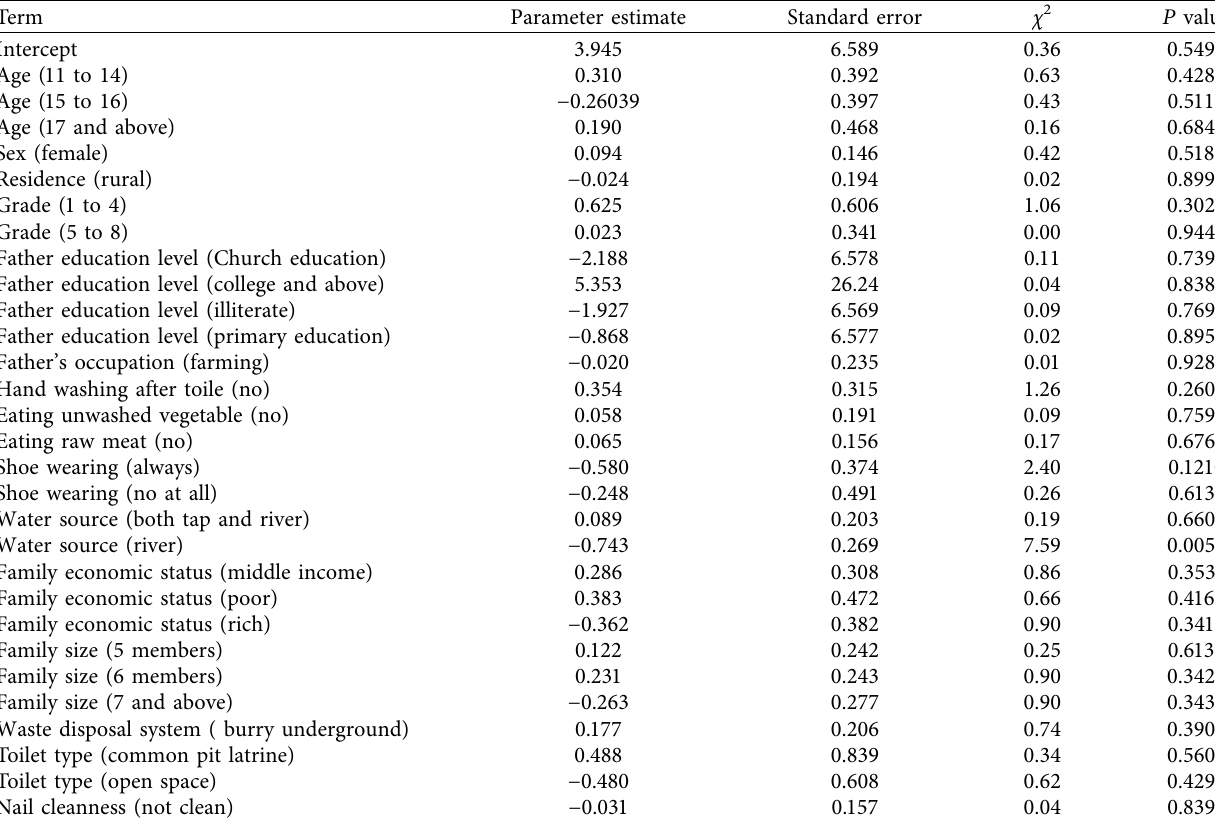
Table 5: Relationship between explanatory variables and G. lamblia infection among school children in Jaragedo town, South Gondar Zone,